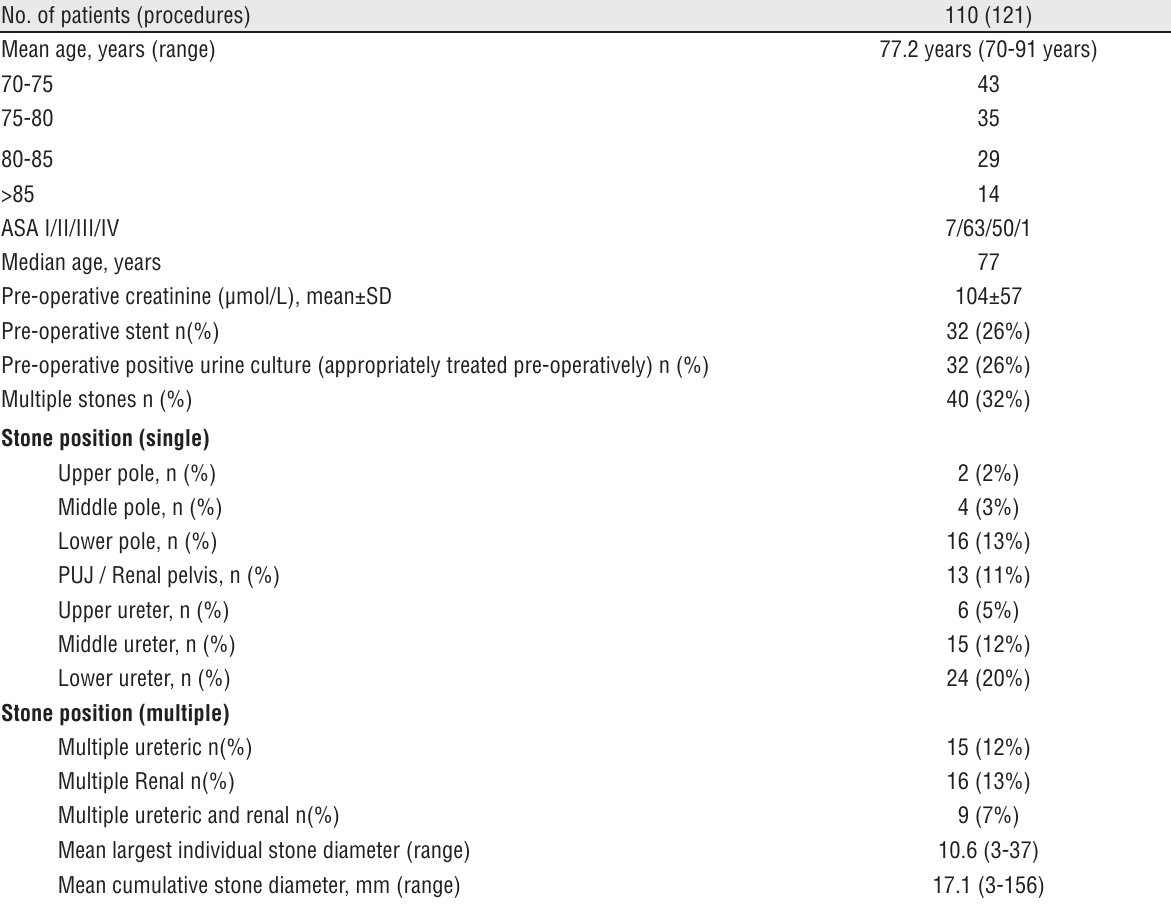
Table 1 - patient demographics and stone location (pUJ – pelvic-ureteric